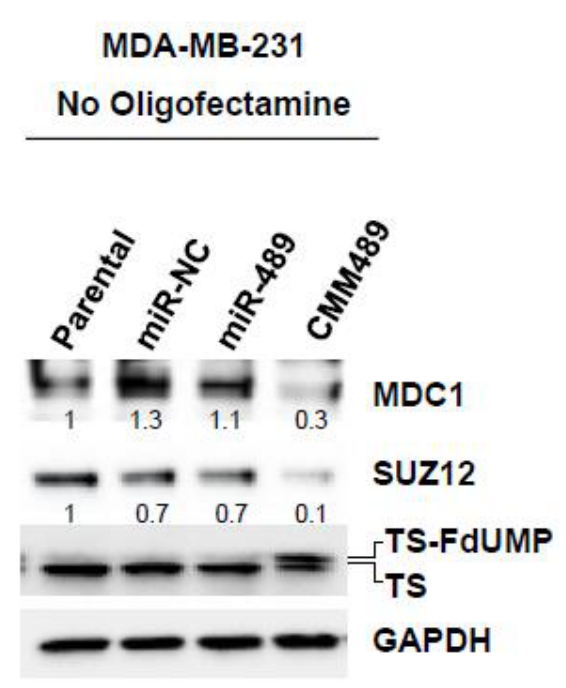
Figure 4. Delivery of 5-FU-miR-489 mimic (CMM489) does not require a transfection reagent. miR-negative control (NC), miR-489 and CMM489 were transfected into MDA-MB-231 cells ( A ) or HCC-1937 cells ( B ) with or without oligofectamine reagent. The density of cells was imaged at 6 days by phase contrast microscopy. Representative images were selected from three independent experiments. Scale bar: 100 µ m. The cell numbers were counted using Trypan blue staining and a hematocytometer. Column, mean from three independent experiments; bars, SD. * p < 0.05, ** p < 0.01, *** p < 0.001. ( C ) Whole cell lysate from MDA-MB-231 cells transfected with the indicated miRNAs without oligofectamine reagent were analyzed by Western blot assay with antibodies against MDC1, SUZ12, TS-FdUMP and β -actin. Densitometric analysis was performed using Image J. Representative images were carried out at least 3 times.